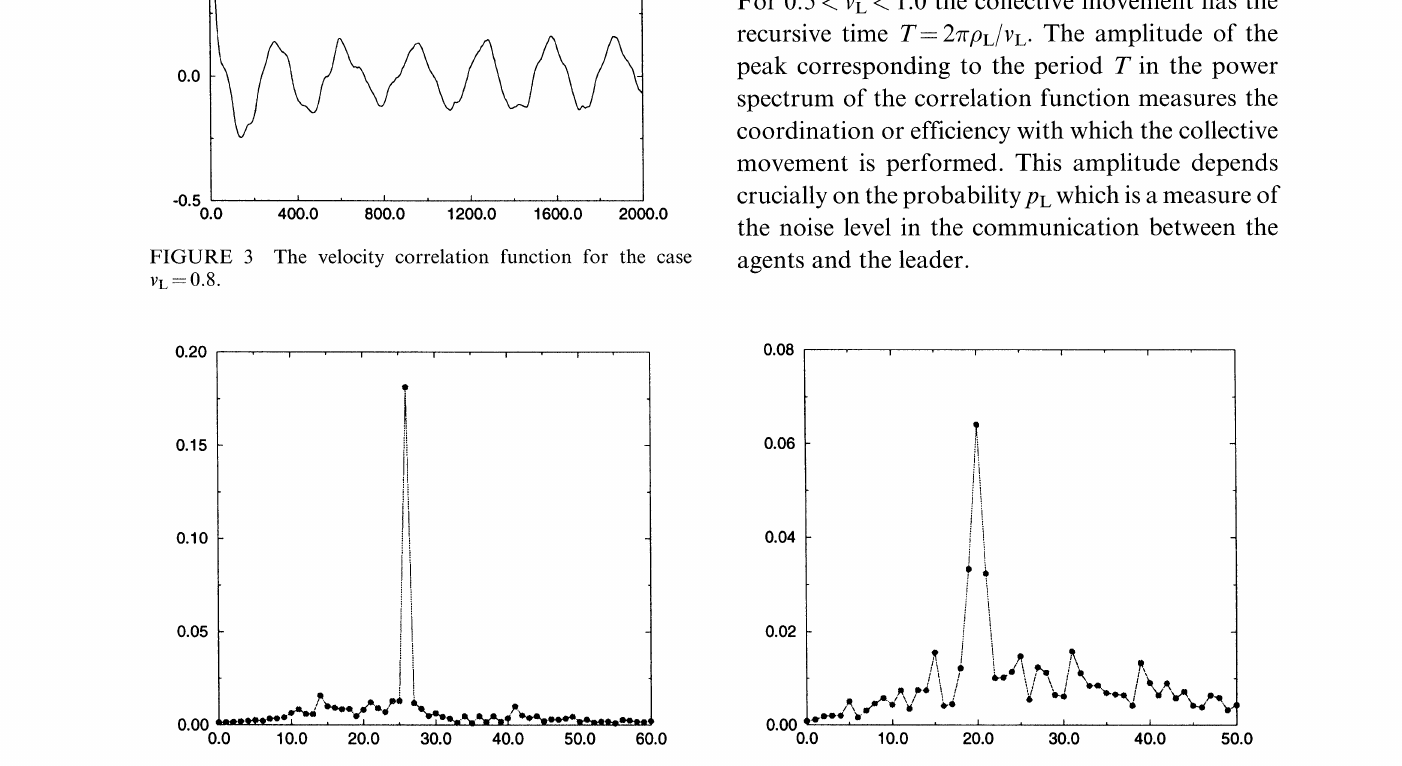
FIGURE 5 The power spectrum of the velocity correla- tion function for vi. =0.6. The frequency of the main peak decreases as v